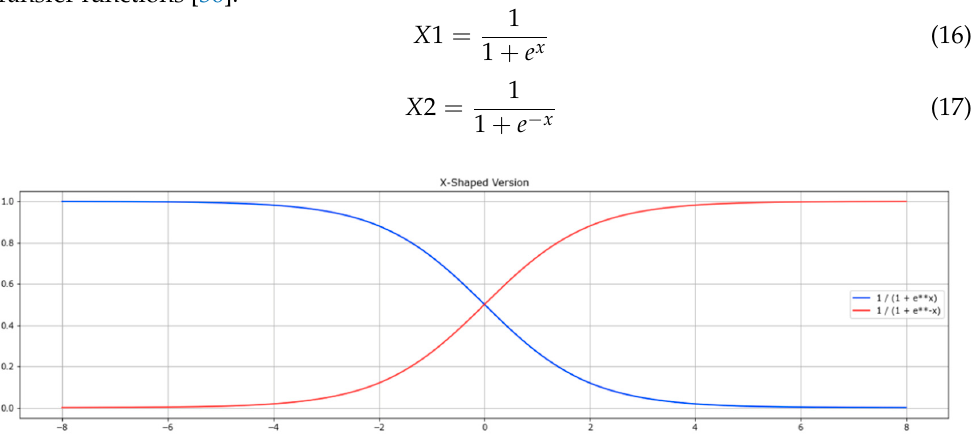
Figure 6. X-shaped transfer function ( X 1– X 2).